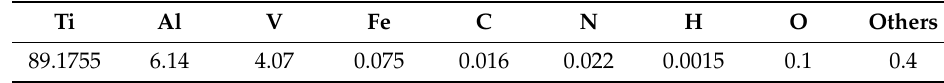
Table 1. Chemical compositions of Ti-6Al-4V titanium alloy (wt%).